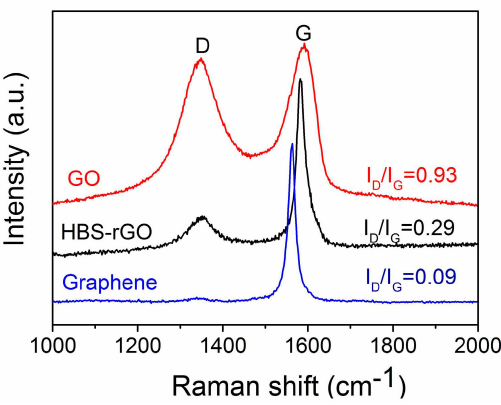
Figure 4. The Raman spectroscopy of GO, HBS-rGO and